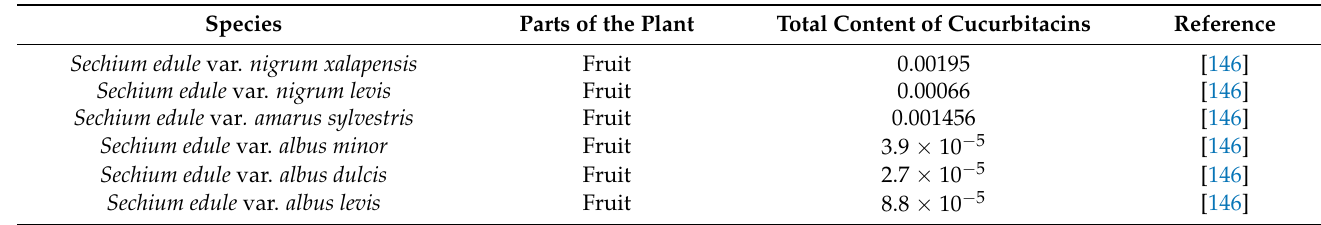
Table 5. Total content of cucurbitacins (mg/g) in different genotypes of Sechium edule